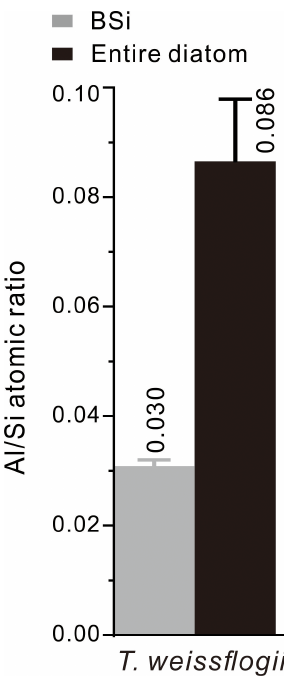
Figure 5. Al / Si atomic ratios of the T. weissflogii diatom cells (the black column) cultured in media with the addition of Al and of their BSi (the grey column). The EDS spot analysis used to determine the Al / Si atomic ratios was based on more than 300 spots on 35 diatom cells and their BSi samples. The error bars were obtained through mean ± standard deviation analysis of all of the Al / Si atomic